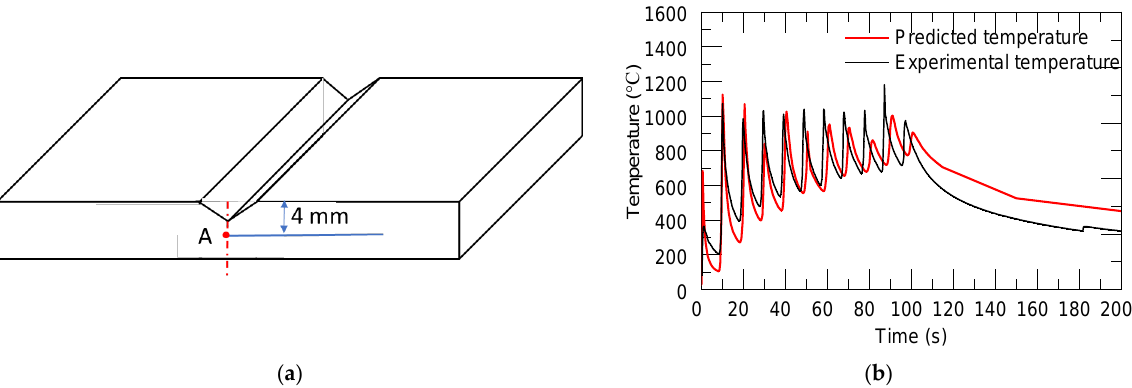
Figure 8. ( a ) The locations of each measurement, Point A (TC1); ( b ) the simulated and measured temperature history.